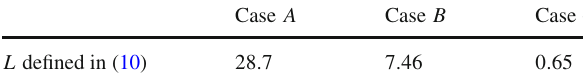
Table 1 Likelihood ratios in the three cases described above. In both the absence of vacuum birefringence effects is favored. This table is incompatible with any strong claim in either direction